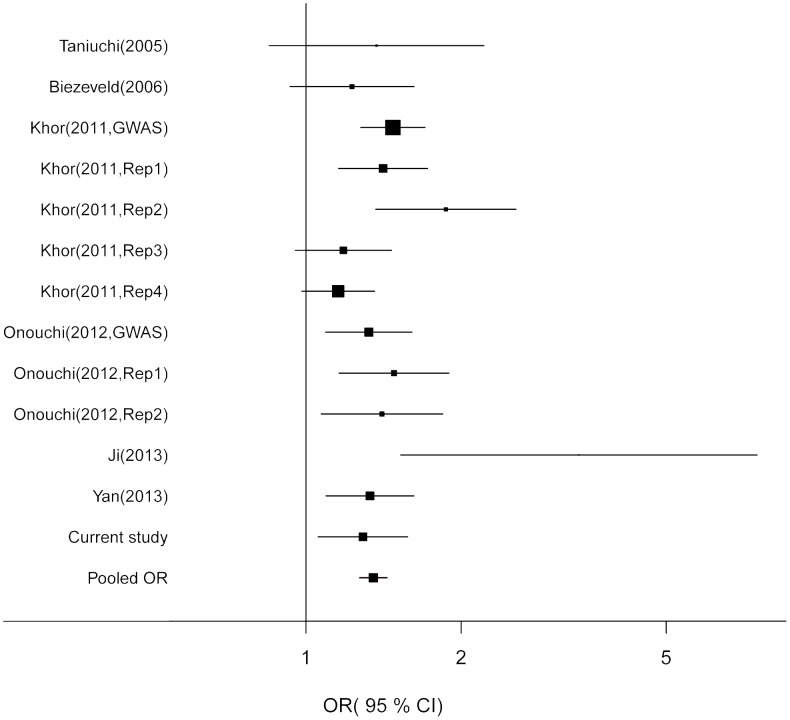
The forest plot for the association between the A allelic variant and the risk of Kawasaki disease.For each study, the estimate of OR and its 95% CI is plotted with a box and a horizontal line. Fixed-effects pooled OR = 1.35, 95% CI = 1.27–1.44, p<0.001; Q = 17.30, P
heterogeneity = 0.139.